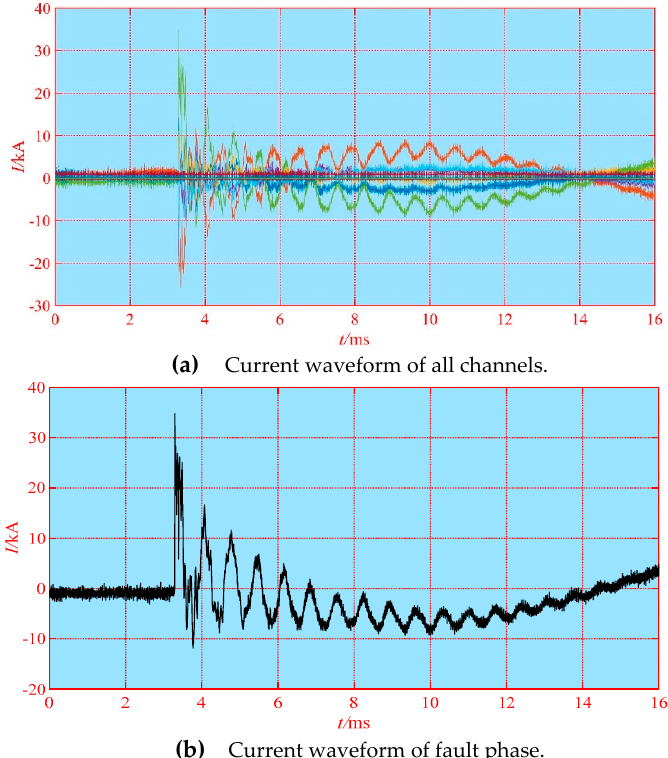
Figure 16. Geographical location map of Yunnan and topological structure of Pu'er 110kV transmission lines.